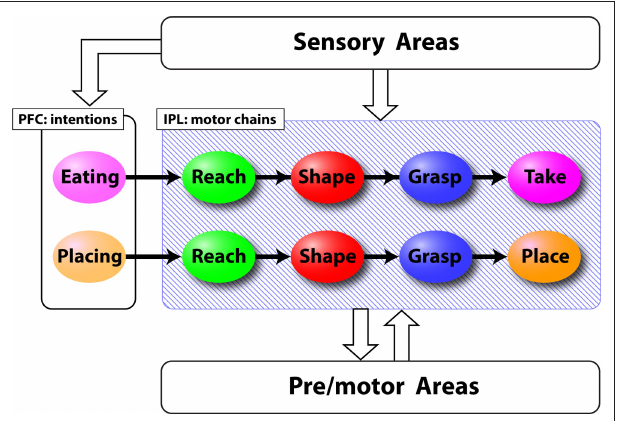
Figure 1 | Schematic representation of the chain model derived from Chersi et al. (2007) . Colored ellipses represent pools of neurons that encode specific motor acts in the parietal cortex (IPL) or intentions in the prefrontal cortex (PFC). Lines indicate the connections between different pools. Sensory areas provide information about the ongoing action and pre/motor areas interpret abstract commands to generate motor